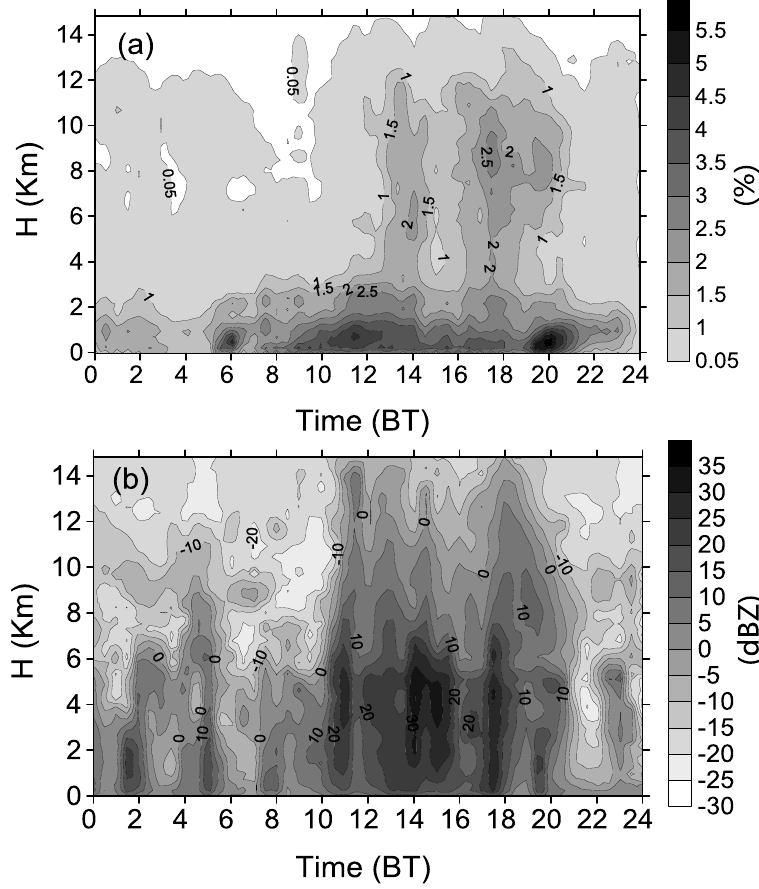
Figure 15. Diurnal variations of ( a ) occurrence frequency of valid merged reflectivity and ( b ) averaged reflectivity at various altitudes during July 2016.